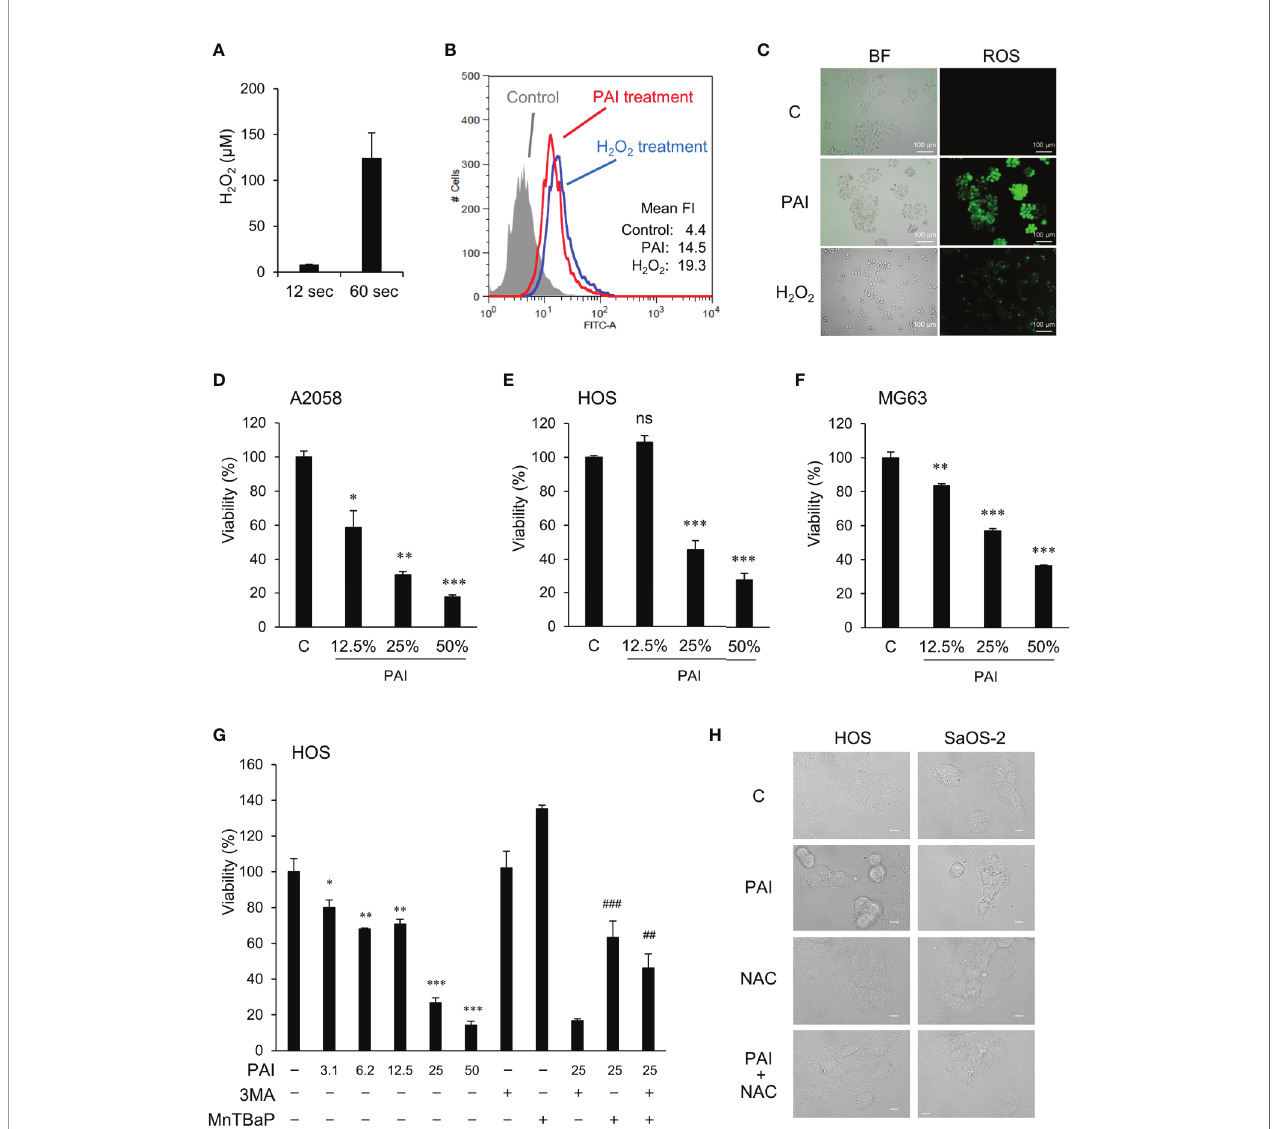
FIGURE 1 | PAI reduces cell viability in MM and OS cells in a ROS-dependent manner. (A) Measurements of H 2 O 2 in PAI. Non-thermal atmospheric pressure helium plasma was irradiated from above at a distance of 20 mm to 5 mL of the infusion fl uid Soldem 3A in a 6-well plate for 1 or 5 min (12 or 60 s/mL). Then, H 2 O 2 concentration in PAI was quantitated using the Amplex Red reagent. Data are the mean ± SD (n = 3). (B, C) Analysis of intracellular ROS generation in live cells. LM8 OS cells (1 × 10 6 ) were labeled with DCFH-DA, treated with PAI (50%) or H 2 O 2 (100 m M), and analyzed by (B) fl ow cytometry and (C) fl uorescence microscopy. Histograms in (B) represent fl uorescence intensity (FI), and green fl uorescence in (C) shows ROS production in the cells treated with PAI and H 2 O 2 . (D – F) PAI reduces cell viability in MM and OS cells. (D) A2058, (E) HOS, and (F) MG63 cells were treated with the indicated PAI concentrations for 72 h and analyzed for viability using the WST-8 cell growth assay. Data are the mean ± SD (n = 3). Data were analyzed by one-way analysis of variance followed by Tukey ’ s post hoc test. * P < 0.05; ** P < 0.01, *** P < 0.001; n.s., not signi fi cant, vs. control treated with vehicle. (G) Effect of 3-MA and MnTBaP on reduced cell viability. HOS cells were treated with the indicated concentrations of PAI alone or in combination with 3-MA (1.3 mM) or MnTBaP (30 m M) for 72 h and were analyzed for viability as described above. Data are the mean ± SD (n = 3). * P < 0.05; ** P < 0.01; *** P < 0.001 vs. control treated with vehicle. ## P < 0.05 vs. PAI + 3-MA; ### P < 0.01 vs. PAI alone. (H) HOS and Saos-2 cells were treated with PAI (25%) or N -acetylcysteine (2 mM) alone or in combination for 18 h and observed under a BZX-710 digital biological microscope with a 100× coverslip-corrected oil objective and were analyzed using BZ-H3A application software. Bar = 10 m